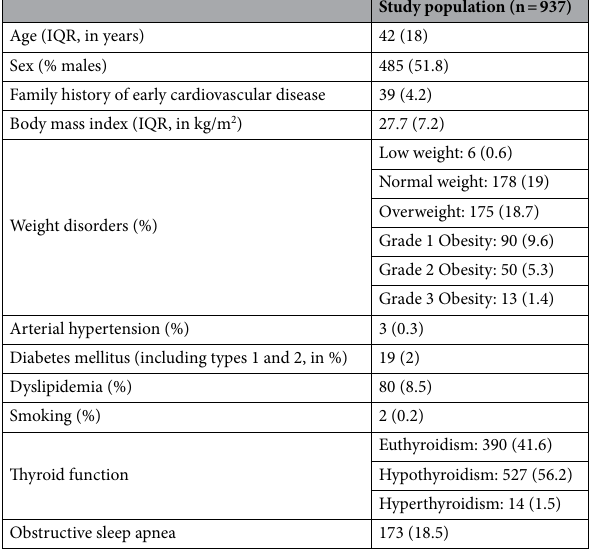
Table 1. Prevalence of cardiovascular risk factors among Spanish adults with Down syndrome. Data are presented as n (%) or median